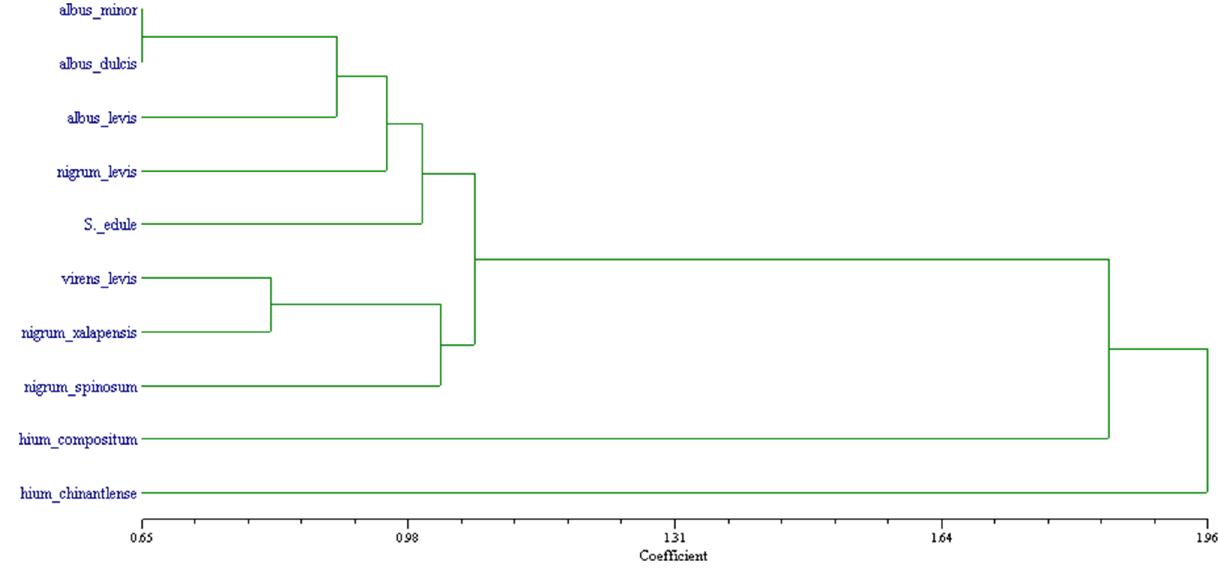
Figure 2. Dendrogram from the coefficient of association or similarity, with the NTSYSpc 62 software, based on 229 multi-state morphological, biochemical, genetic, and biological activity variables of fruits from ten Sechium spp.